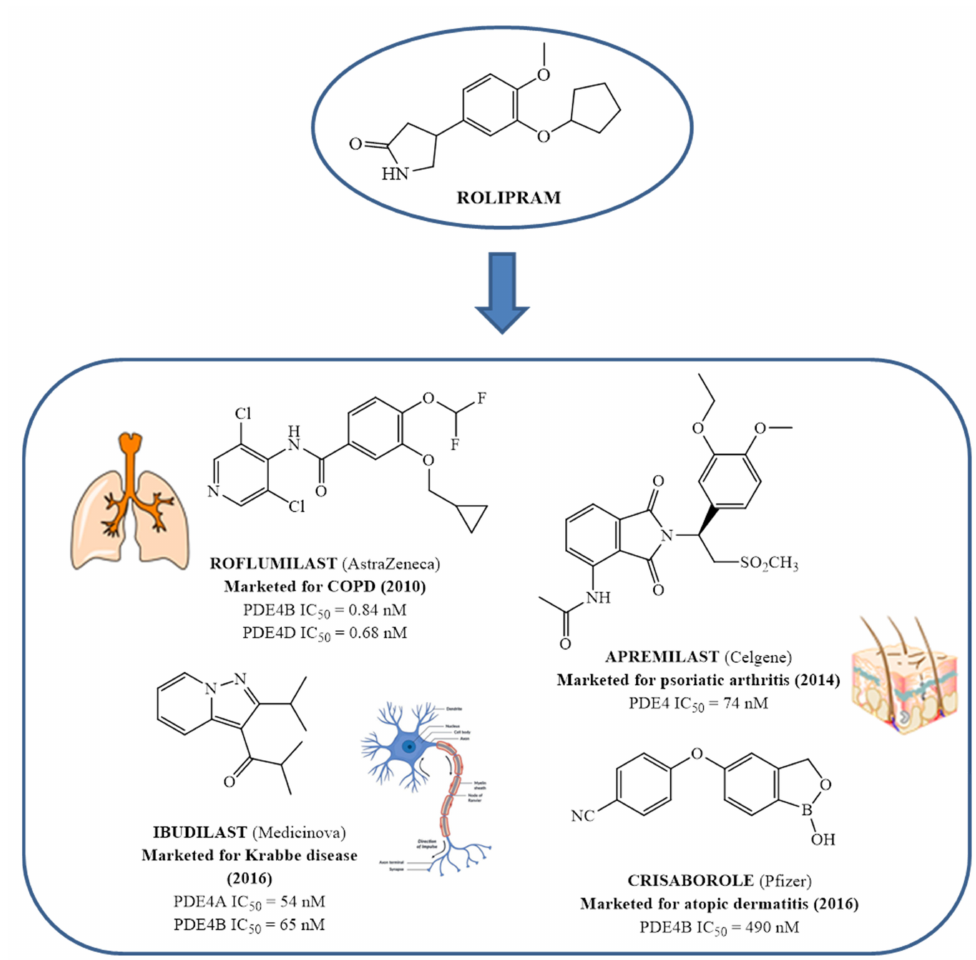
Figure 4. From Rolipram to marketed PDE4